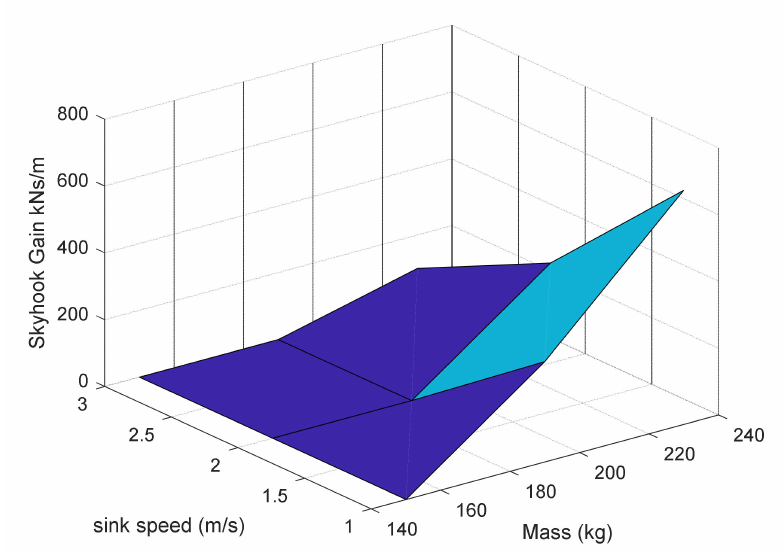
Figure 7. Skyhook gain